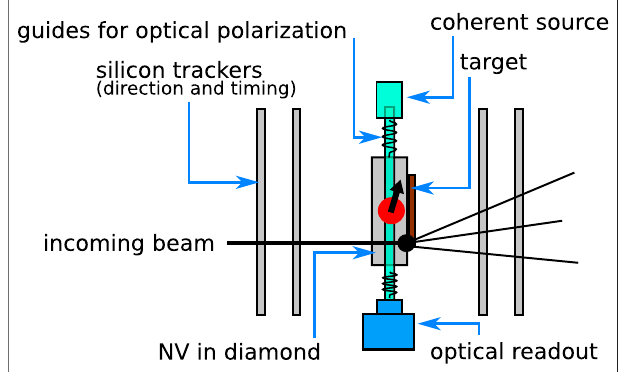
FIGURE 4 | Scheme of an active target based on polarized NV ’ s in diamond used to sense the remaining heavy and slow spectator fragments. The sketch shows the silicon trackers, the target material and the optoelectronic system used to prepare the diamond for the measurement and to perform the